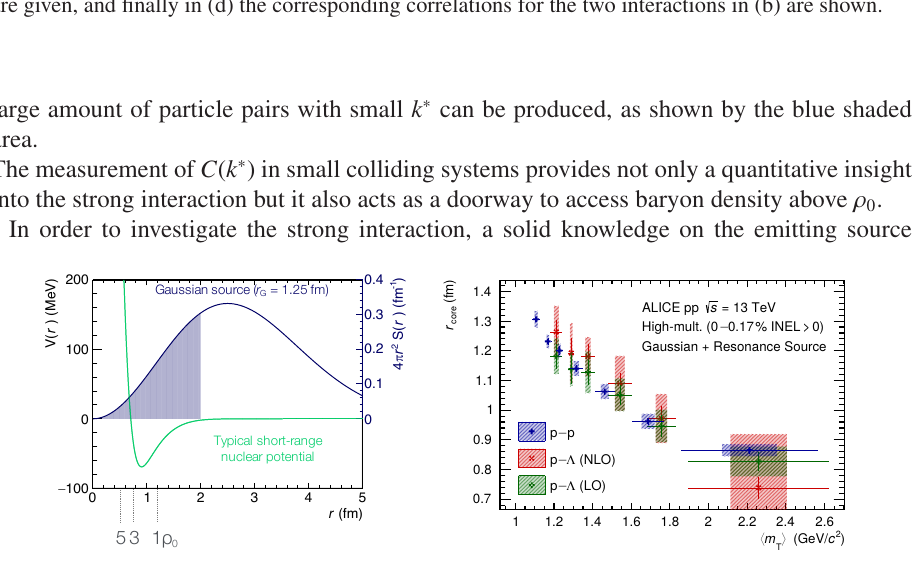
Figure 1. Figure taken from [13]. Schematic representation of the femtoscopy technique. In (a), a sketch of the source from which the pair of interest is emitted is shown, while in (b) two examples of interacting potential are presented. In (c) both the theoretical and the experimental definition of C ( k ∗ ) are given, and finally in (d) the corresponding correlations for the two interactions in (b) are shown.